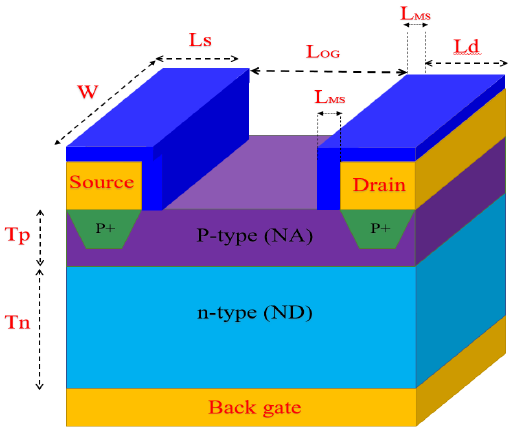
Figure 5. Schematic of OG-FET sensor showing the main material composition of the sensor. tn >> tp and tp >> n++ in terms of thickness. Blue color is the SiO 2 /Si 3 N 4 layer shown in the fabrication process (see Figure 3) that is used for passivation. Table 1. Design parameters used in simulation and fabrication of OG-JFET.